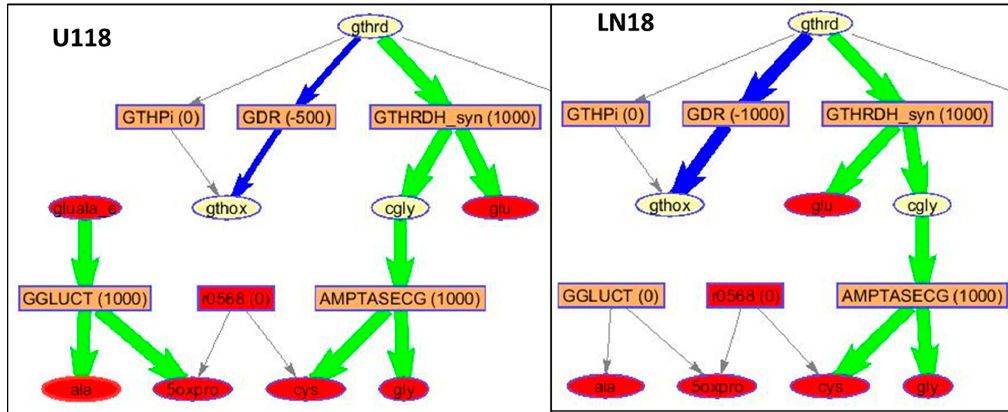
synthesis of 5-oxoproline are higher in U118 cells. This simulation-based observation is in agreement